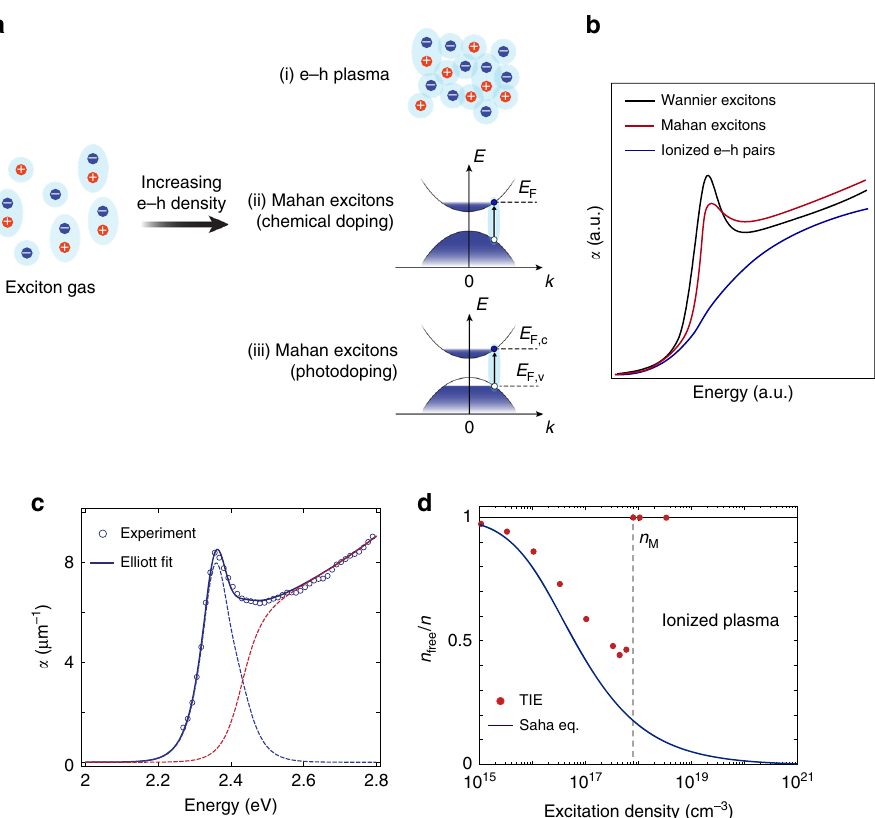
Fig. 1 Absorption spectra and exciton ionization ratio. a Evolution of the bound exciton gas in a bulk semiconductor with increasing carrier density. Two scenarios are possible: (i) bound excitons are ionized into an e – h plasma and the Mott transition to a metallic state takes place; (ii), (iii) e – h correlations still persist in the form of Mahan excitons, i.e. bound states in the Fermi sea in a (ii) chemically-doped and (iii) photodoped semiconductor. E F indicates the Fermi energy; E F,c and E F,v represent the quasi-Fermi energies of the conduction band and valence band, respectively. b Schematic representation of the optical absorption spectrum of a bulk semiconductor in the presence of Wannier excitons (black curve), and its modi fi cation at high carrier densities. The Mott transition manifests itself with the ionization of the Wannier exciton (blue curve), whereas the Mahan exciton scenario features the persistence of the Wannier peak and the enhancement of the absorption continuum (red curve). c Absorption spectrum of CH 3 NH 3 PbBr 3 single crystals as obtained from the ellipsometry data (dots), fi tted with Elliott theory (solid line) and resulting in a binding energy E b = 71 meV, linewidth Γ = 34 meV, and single- particle gap energy E g = 2.42 eV. The blue and red dotted lines represent the distinct contributions of the Wannier exciton and the continuum, respectively. d Exciton ionization ratio as a function of the excitation density, where n free ∕ n = 0 corresponds to an exciton gas and n free ∕ n = 1 to a fully ionized plasma, as calculated from the theory of ionization equilibrium (TIE, red dots). The vertical line indicates the Mott critical density, found at n 17 cm − 3 . The solid line represents the ionization ratio calculated with the Saha equation, and it is added for M ~ 8 × 10